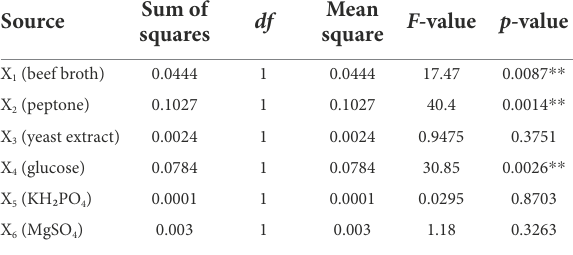
TABLE 2 Analysis of the significance of PB